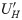
All local optima found for the model for each speed based on a Belgian Malinois morphology.Each row corresponds to a given speed condition, and each data point is a feasible local optimum arising from energy optimization from one random guess, with relative cost (CoT—min CoT for a given UH′) indicated by color. Solutions are plotted in terms of Hind Lag (HL), Pair Lag (PL) and Fore Lag (FL), defined in Fig 5B. As speed increases, solutions become more variable. Pseudo-global optimal solutions for each case are shown in Fig 8. Bottom row: Some recognizable gaits and their positions in the plots. Dashed line: hind symmetry; dotted line: fore symmetry; dot-dash line: simultaneous right-hind and left-front contact (as in a canter). Black square: diagonal singlefoot; white square: lateral singlefoot; black diamond: pace; white diamond: trot; black triangle: rotary gallop; white triangle: transverse gallop; black circle: perfect symmetry.